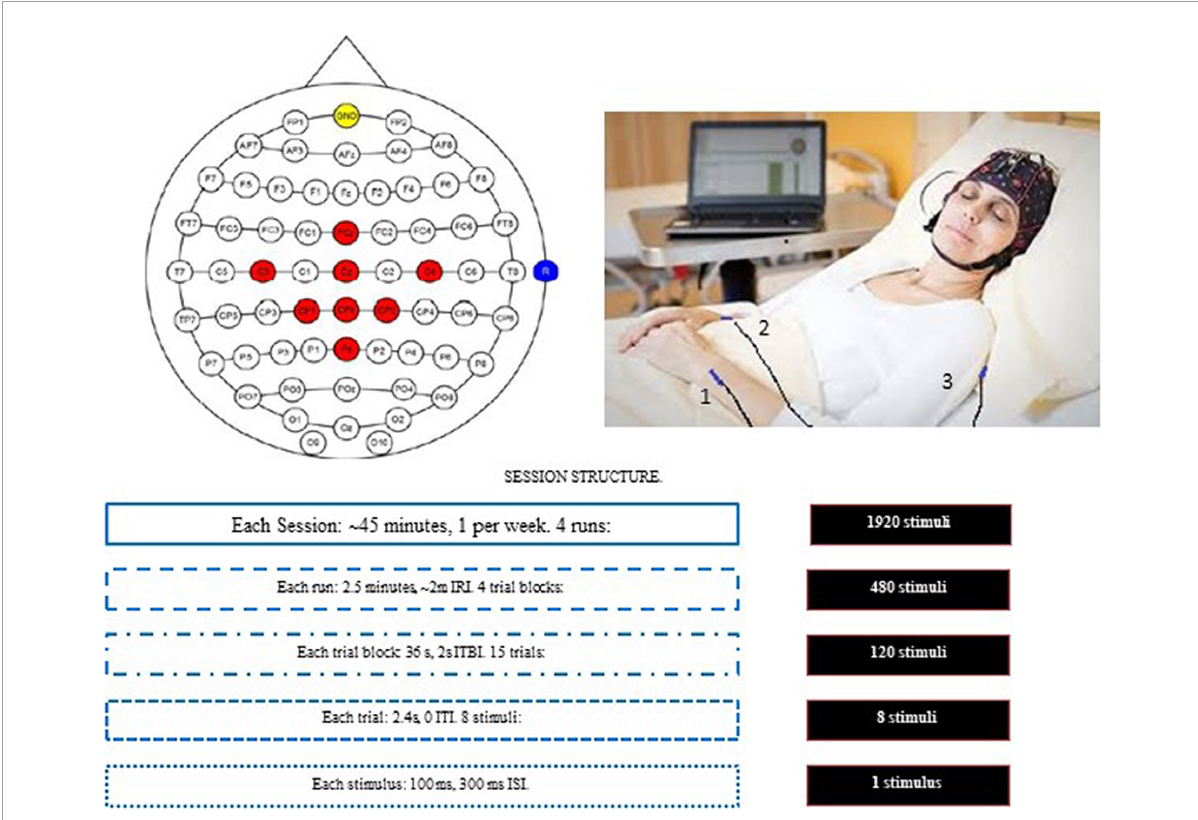
FIGURE1 The experimental paradigm. Top left: electrode montage. The red spots mark the positions of eight active EEG electrodes. The reference was placed on the right earlobe (blue) and the ground electrode was at FPz (yellow). Top right: the position of the three vibrotactile stimulators: 1 (left wrist); 2 (right wrist); and 3 (back). Each trial had eight stimuli: six were to vibrotactile stimulator 3, and 1 (each) to vibrotactile stimulators 1 and 2. Bottom: The components within each session. IRI, inter-run interval; ITBI, Inter-trial block interval; ITI, Inter-trial interval; ISI, Inter-stimulus interval. The boxes on the right show the number of stimuli for that